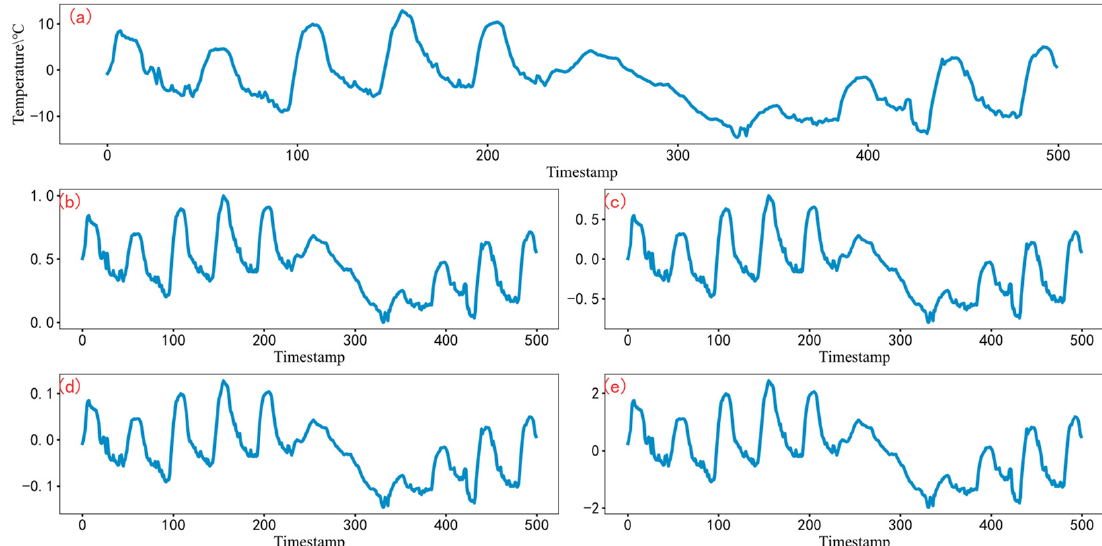
Figure 2. Comparison of the effects of four normalization methods; ( a ) the input data; ( b ) the effect after using Min-Max normalization, it normalizes the data to the range of (0–1); ( c ) the effect after using interval normalization, it normalizes the data to the range of ( − 0.8–0.8); ( d ) the effect after decimal calibration normalization, it normalizes the data to the range of ( − 0.1–0.1), and ( e ) the effect after z-score normalization, it normalizes the data to the range of ( − 2–2).